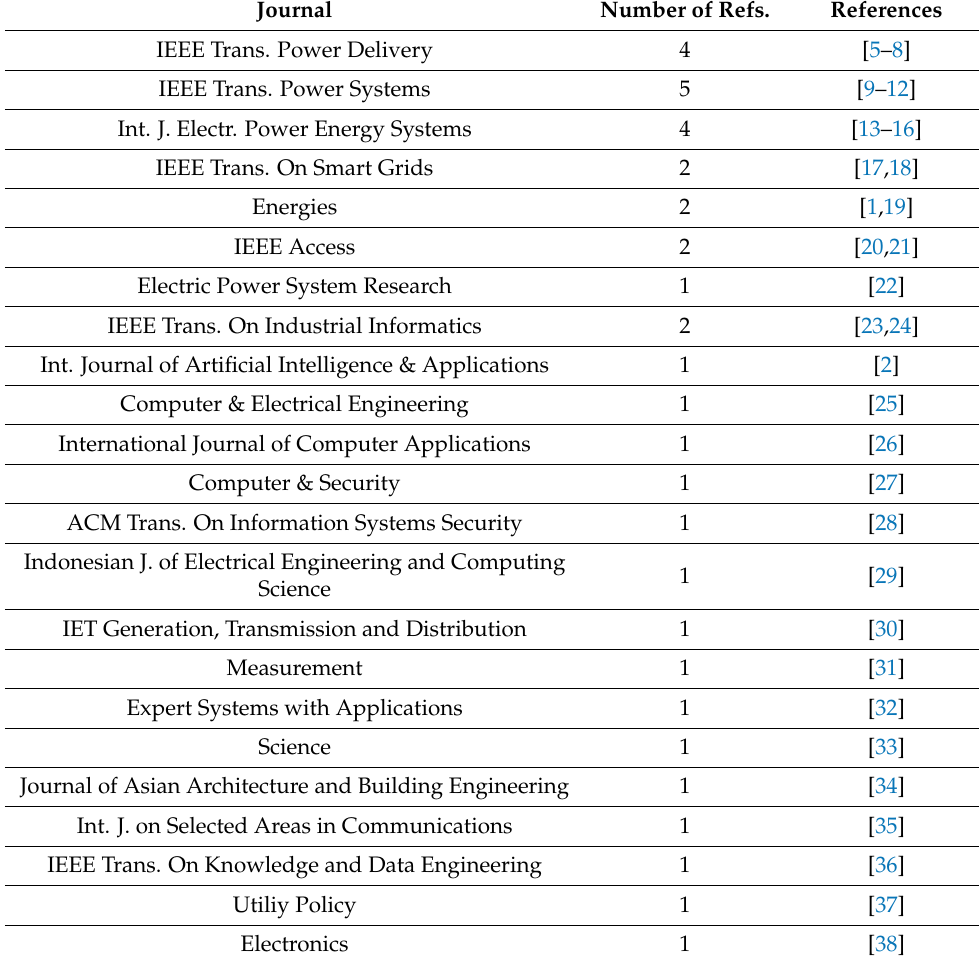
Table 2. Selected papers according to publication